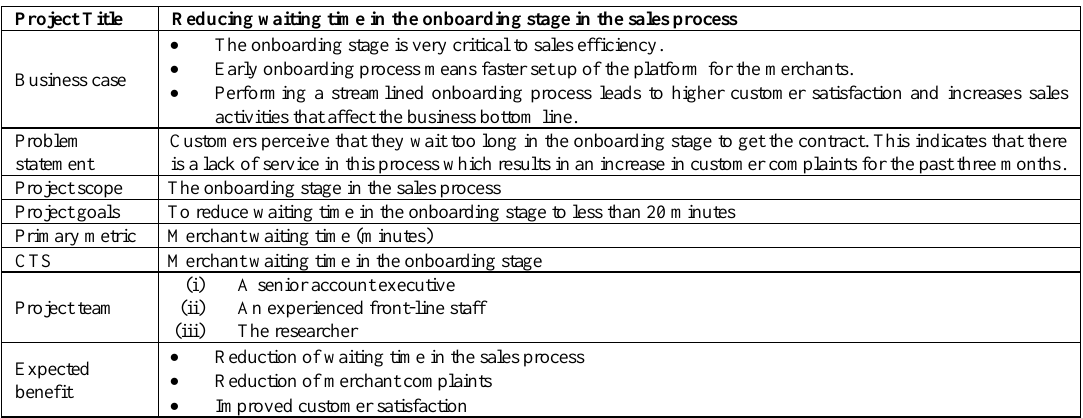
Table 1. Project